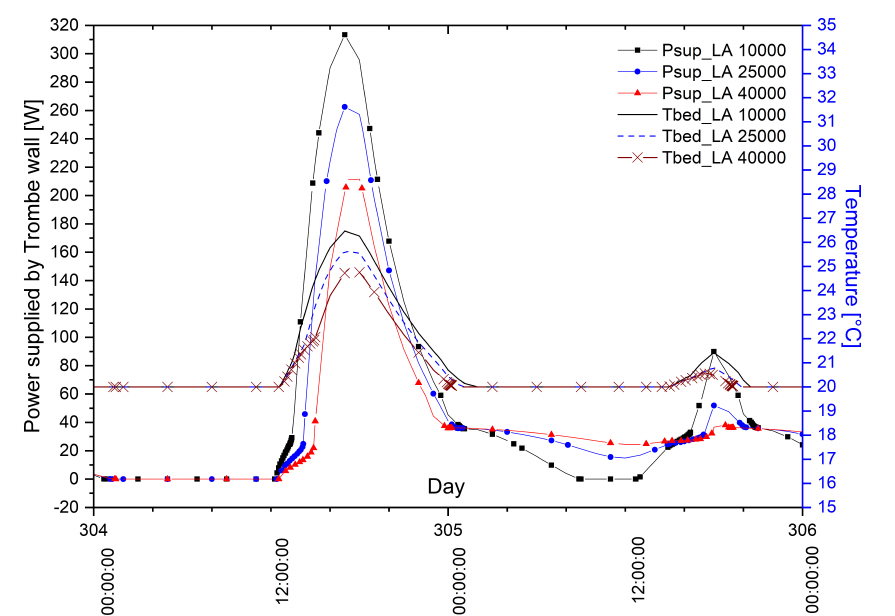
Figure 4. Effect of latent heat on the power released by the solar Trombe wall and temperature inside the